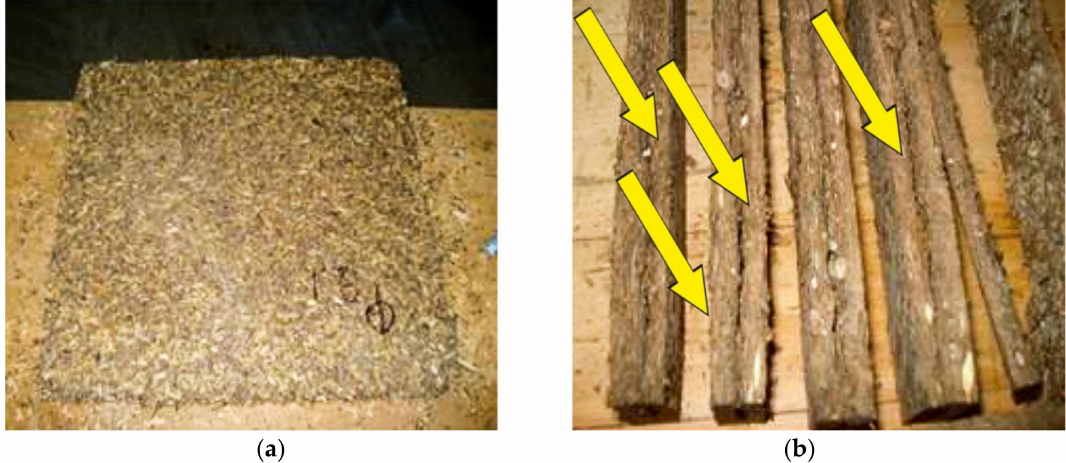
Figure 4. Cracks (blows) in the core layer of boards made with 50% PO leaves, ( a ) after hot pressing; ( b ) after